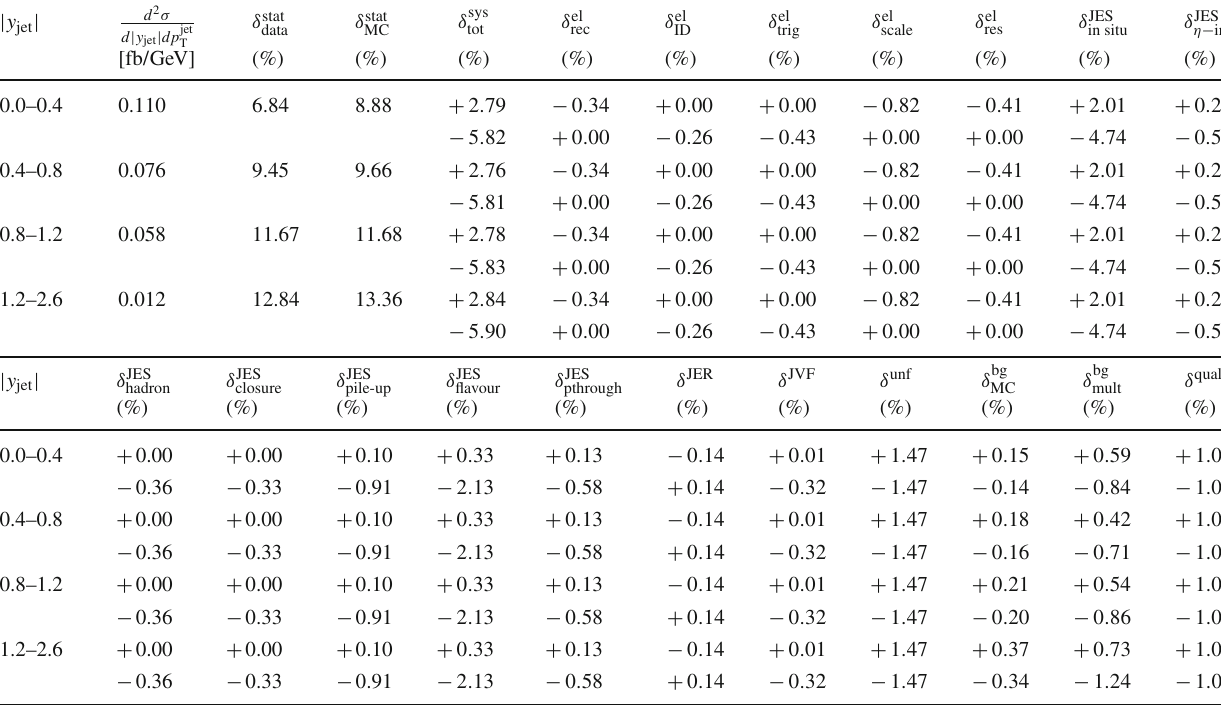
Table 8 The measured double-differential Z + jets production